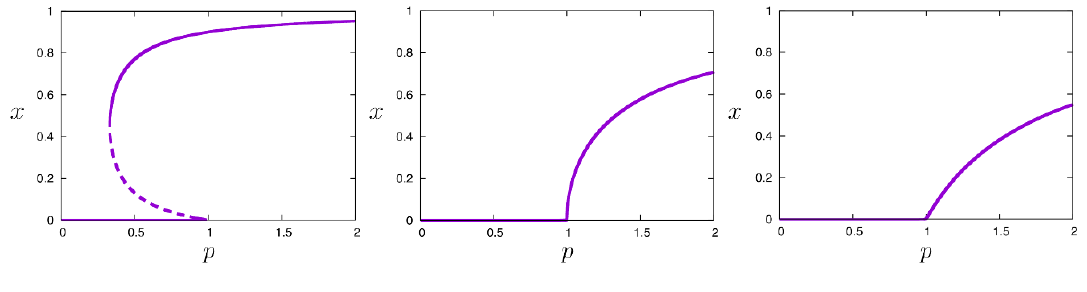
Figure 2 . x (cid:17) N trail versus p in the ant trail model (3.3). (cid:11) = 1, ~ s (cid:17) s N and 5 : 0 (right), N = 10 5